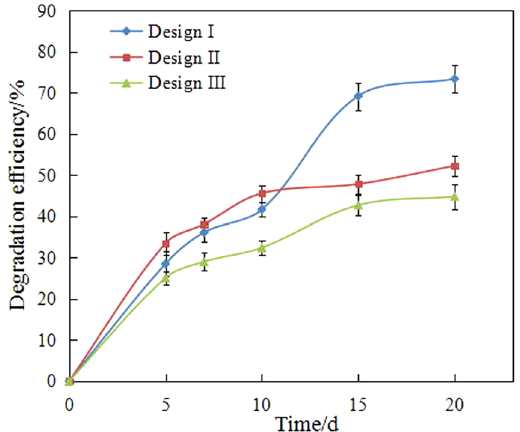
Figure 3. Degradation efficiency of diesel vs remediation time during by different bioremediation method. Design I: immobilized bacteria by wood chips; Design II: immobilized bacteria by maize straw; Design III: Free bacteria.